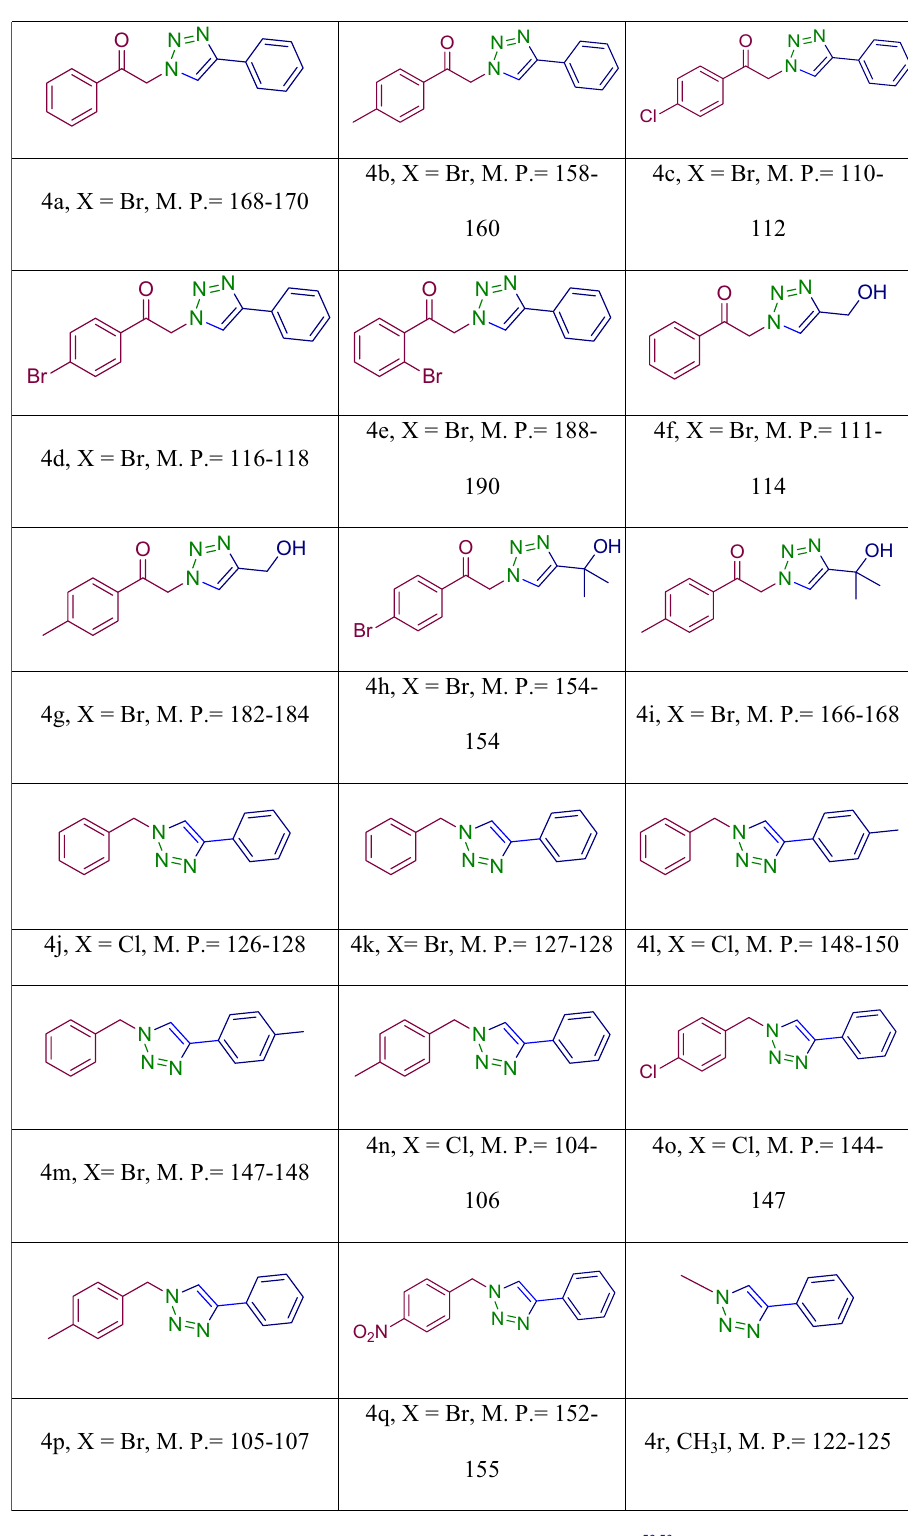
Table 2. Synthesis of 1,2,3-triazoles in the presence of Fe 3 O 4 -g-C 3 N 4 -Alginate-Ag 52,53